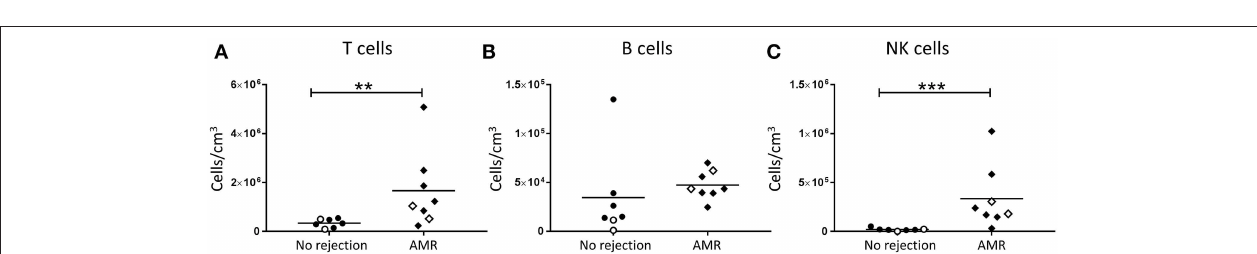
expression levels of activation marker CD69 were elevated on CD56 bright NK cells in the borderline/TCMR group compared with non-rejecting biopsies ( Figure 4C ), whilst CD69 expression levels on CD56 dim NK cells were comparable between the two groups ( Figure 4D